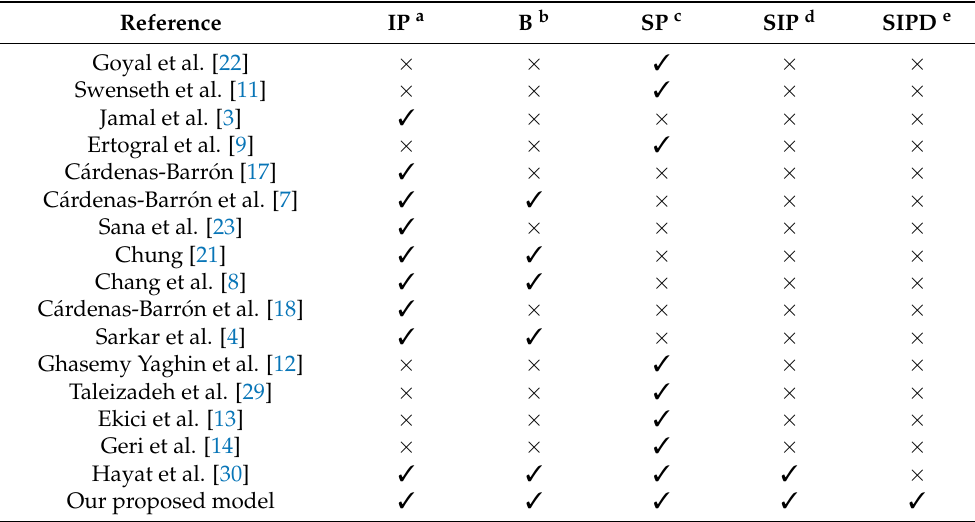
Table 1. Comparison of the proposed research with existing literature.